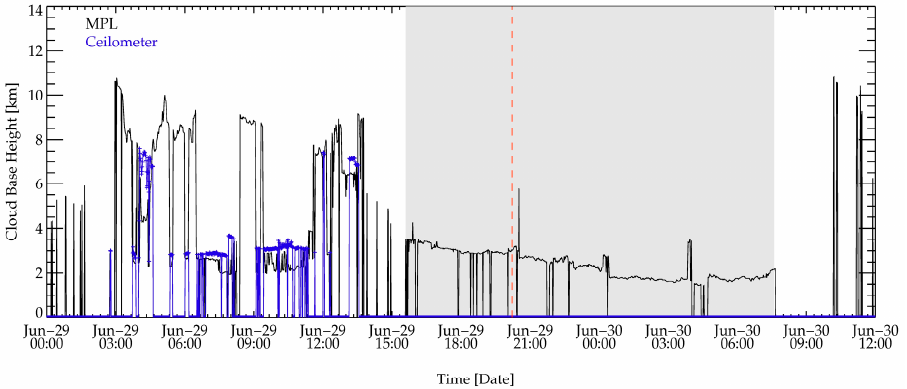
Figure A3. Time series of CBH from ceilometer (blue solid line) and MPL (black solid line) on 29 and 30 June 2015.